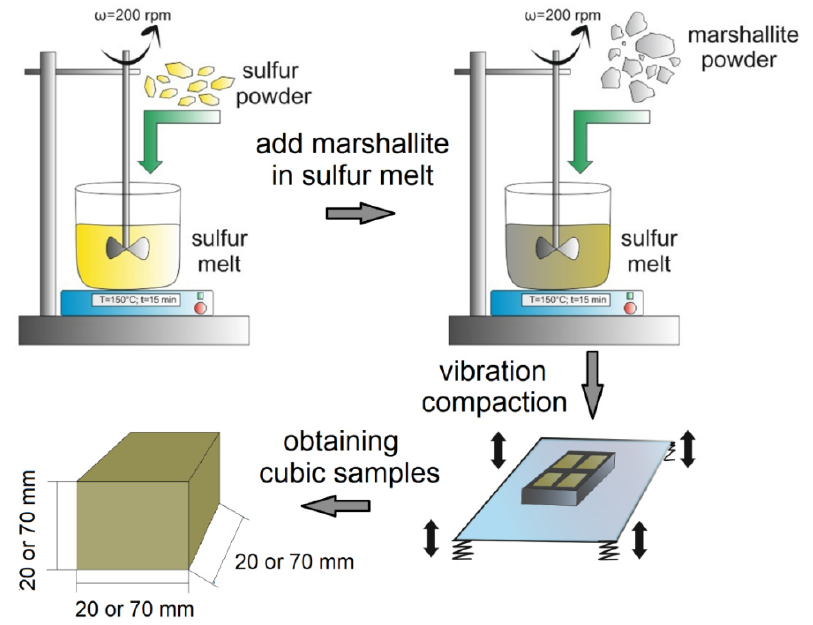
Figure 2. Diagram of an experimental setup for the manufacture of material on sulfur binder (sulfur concrete) (single-column fitting image).